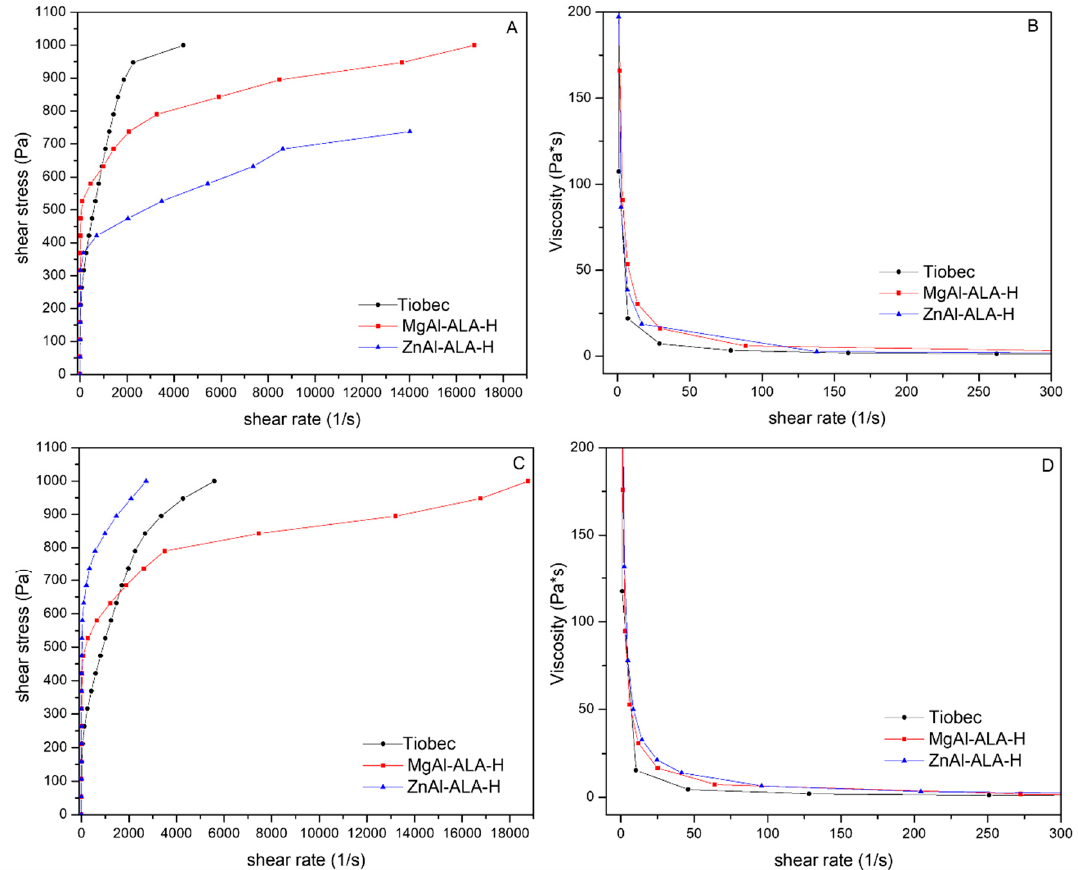
Figure 4. Shear stress vs. shear rate for hydrogels MgAl-ALA-H, ZnAl-ALA-H, and Tiobec ® at: 25 °C ( A ) and 32 °C ( C ); Viscosity vs. shear rate for hydrogels MgAl-ALA-H, ZnAl-ALA-H, and Tiobec ® at 25 °C ( B ) and 32 °C ( D ).